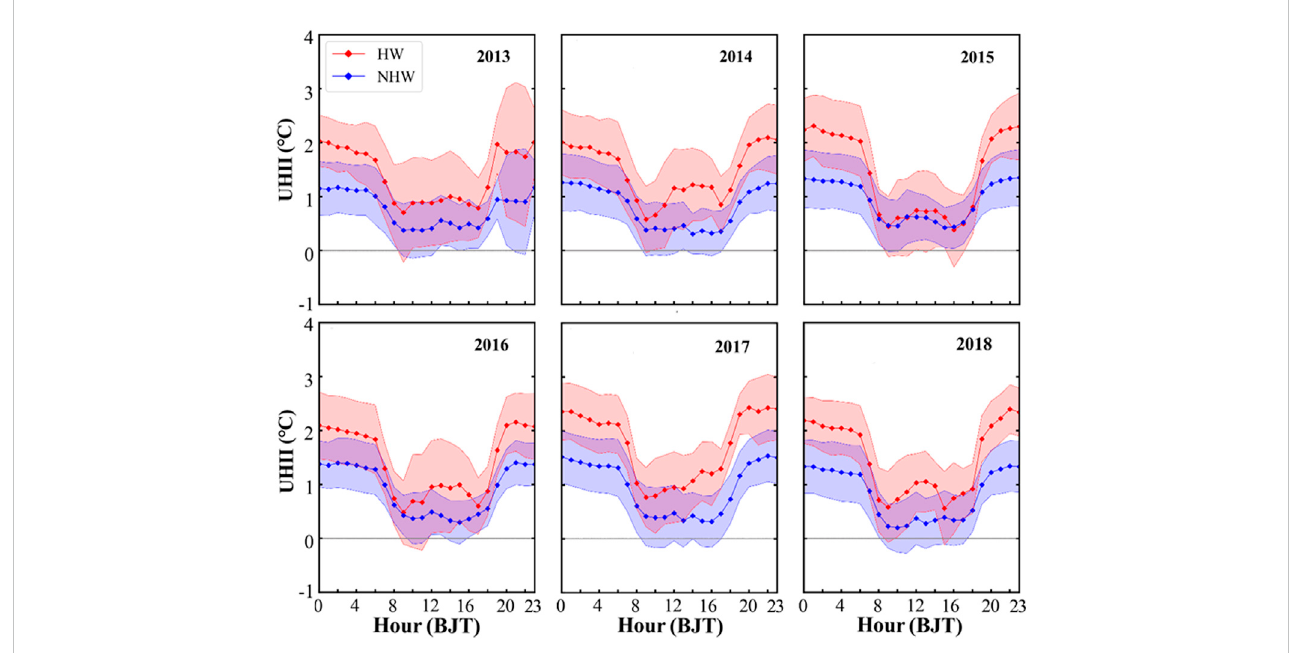
FIGURE 4 Diurnal variation in UHII in Guangzhou during HW and NHW periods during 2013 – 2018 (BJT: Beijing time). The red and blue shaded areas represent the annual standard deviation of HW and NHW periods, respectively.